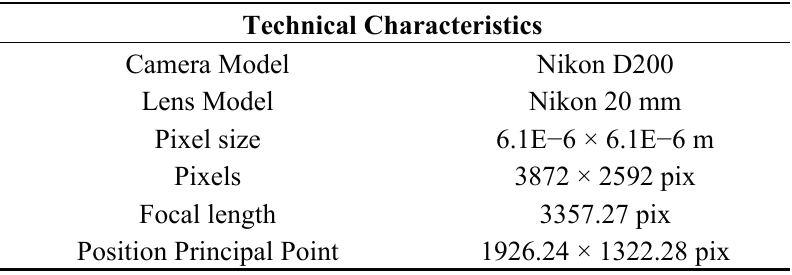
Table 2. Technical specifications of the Nikon D200